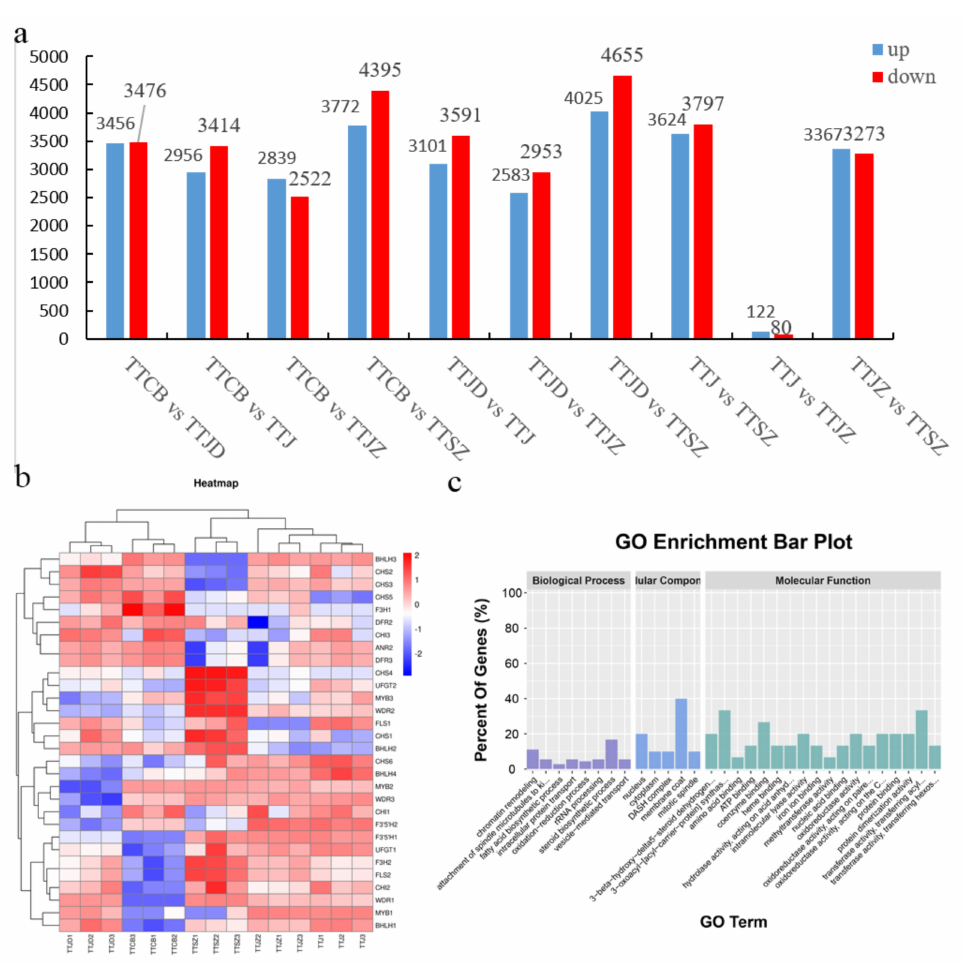
Figure 5. DEG analysis of flowers of different colours in C. tientaiensis . ( a ) The number of DEGs iden- tified in every comparison group. The blue/red bars represent the numbers of up/downregulated genes. ( b ) Heatmap of DEGs of flowers of different colours in C. tientaiensis . ( c ) GO term of spe- cific